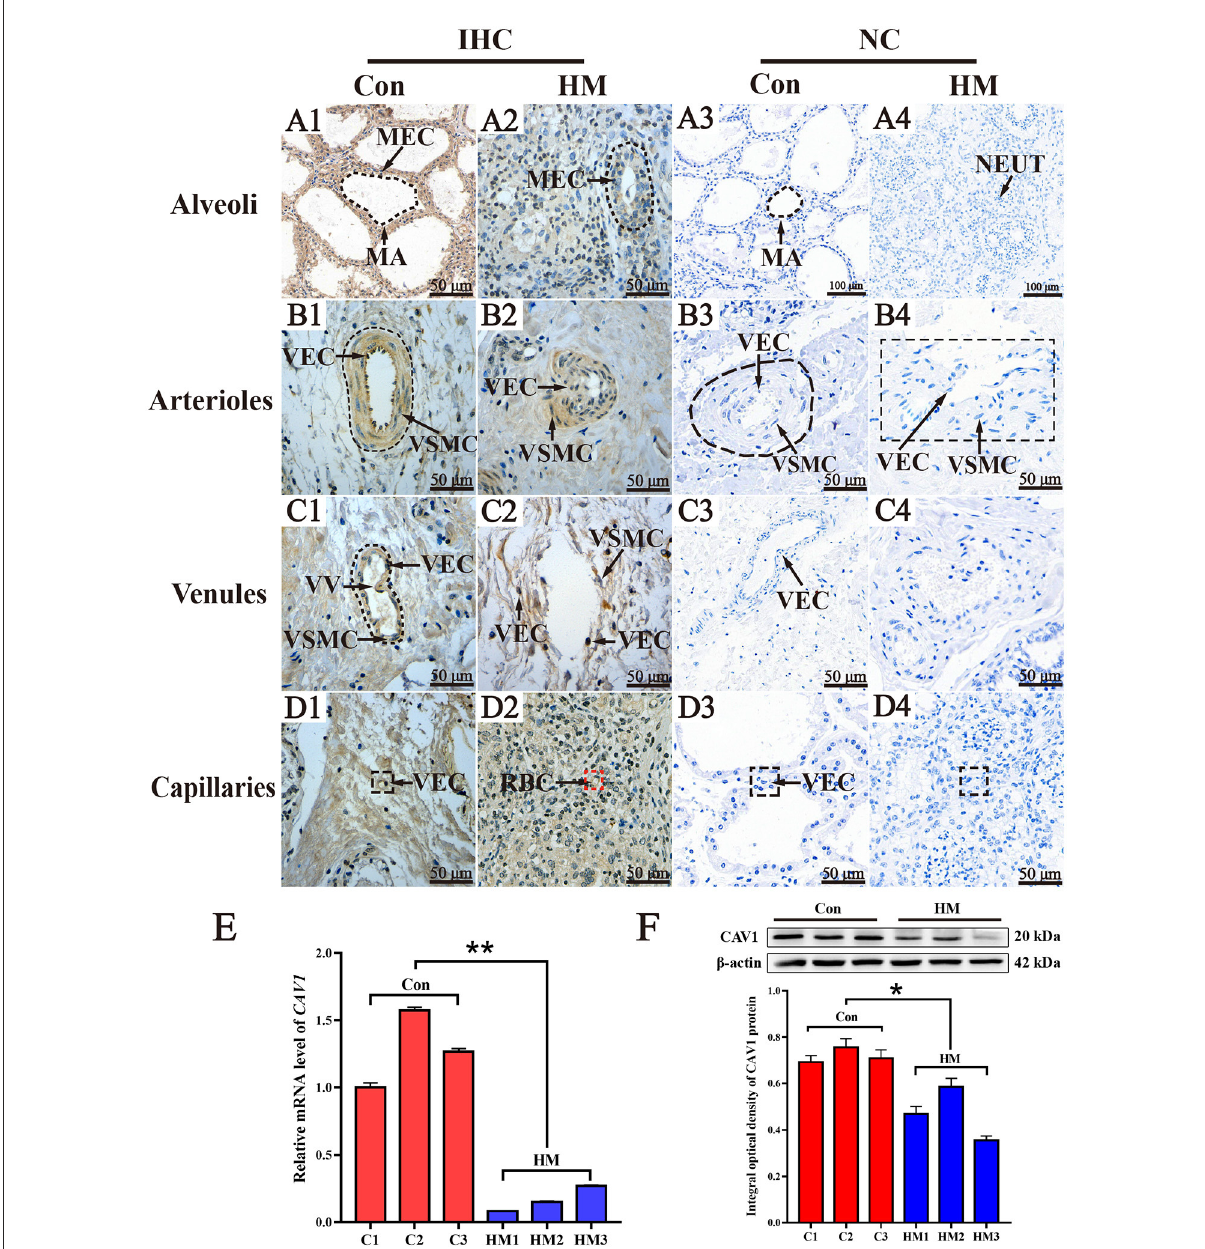
FIGURE7 The subcellular location, mRNA and protein analysis of CAV1 in the mammary glands of healthy Holstein cows with hemorrhagic mastitis. (A1–D1,A2–D2) the subcellular location of CAV1 protein in the alveolus, arteriole venules and capillaries of the mammary glands in the C and HM groups, respectively. (A3–D3,A4–D4) the negative control mammary glands of Holstein cow, respectively. (E,F) the relative expression of CAV1 mRNA and protein in the C and HM groups, respectively. MEC, mammary epithelial cells; MA, mammary gland alveolus; VEC, vascular endothelial cell; VSMC, vascular smooth muscle cell; NEUT, neutrophil; VV, venous valve; Con or C, control group, the mammary gland of healthy Holstein cow; HM, hemorrhagic mastitis group, the mammary gland of Holstein cow with hemorrhagic mastitis. Scale bar of 50 and 20 µ m represents 400 × and 800 × magnification, respectively. * , significant difference; ** , extremely significant difference.